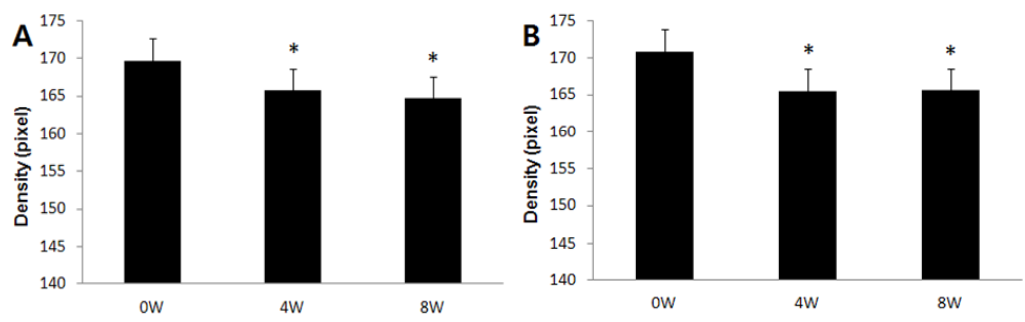
Figure 8. Changes in hyperpigmentation density following 8 consecutive weeks’ use of corn silk extract (mean ± SEM, * p < 0.05 vs. before treatment). ( A ) corn silk extract 0.75% aqueous solution; ( B ) corn silk extract 1.5% aqueous solution.